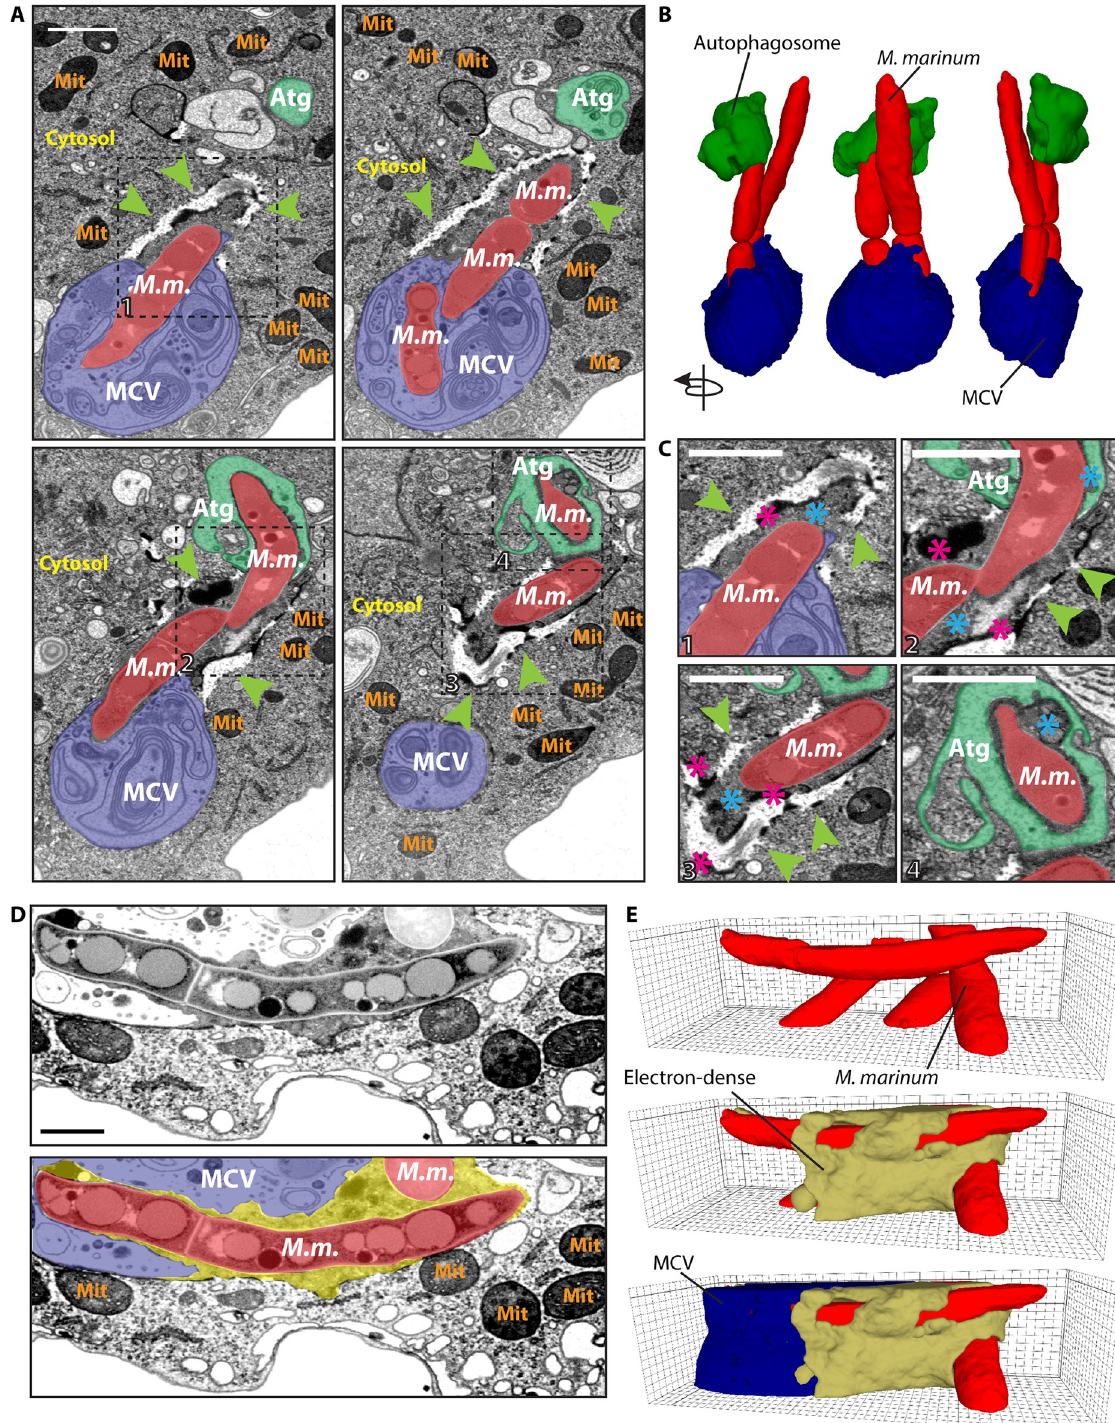
Fig 1. The ultrastructure of the MCV at the point of rupture reveals a complex battlefield between the M . marinum and its host. D . discoideum was infected with M . marinum and fixed at 24 hpi for visualization by FIB-SEM. (A) Sections of the same infected cell, showing a disrupted MCV (blue), M . marinum (red) accessing the cytosol and a potential autophagosome (green) engulfing the pole of a cytosolic bacterium. Green arrowheads point to a complex structure with discontinuities and electron-dense boundaries surrounding the cytosolic M . marinum . Squares delimitate the areas of interest magnified in C. (B) 3D reconstruction of the FIB-SEM stack shown in A. (C) The cytosolic